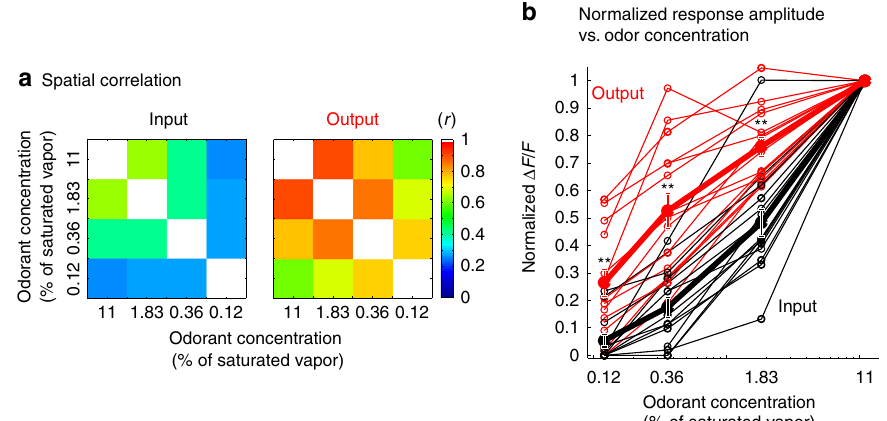
Fig. 3 Population summary of the spatial correlation of the activity maps and signal size vs. odor concentration. a The mean spatial correlation of each frame subtraction map with the map from the other three concentrations. The activity maps of the output ( right ) are more similar to each other than are the activity maps of the input ( left ). This summary includes 14 measurements from 13 preparations (responses to two different odorants were measured in one preparation). b Normalized signal size vs. odorant concentration for 15 measurements in 14 preparations ( thin lines , two different odor responses were measured in one of the preparations). The average of the 15 measurements is shown as the thick lines . The input signals ( black ) decline much more rapidly as the odor concentration is reduced. In same hemi-bulb preparations, all activated glomeruli that could be identi fi ed for both input and output were included. In opposite bulb preparations, input and output glomeruli were counted if they were activated by 1.83% of saturated vapor. Panel a includes 13 measurements using methyl valerate and 1 using isoamyl acetate. Panel b includes 1 measurement using ethyl tiglate, 13 using methyl valerate, and 1 using isoamyl acetate. The results from the different odorants were not qualitatively different. The error bars represent s.e.m., ** p < 0.005. A repeated measures ANOVA and Wilcoxon rank sum test were used for the statistical analysis. Detailed experimental and statistical information for panels a and b are included in Supplementary Tables 1 and 2, GCaMP6f (Supplementary Fig. 3; 1.83%: p < 0.001; 0.36%: